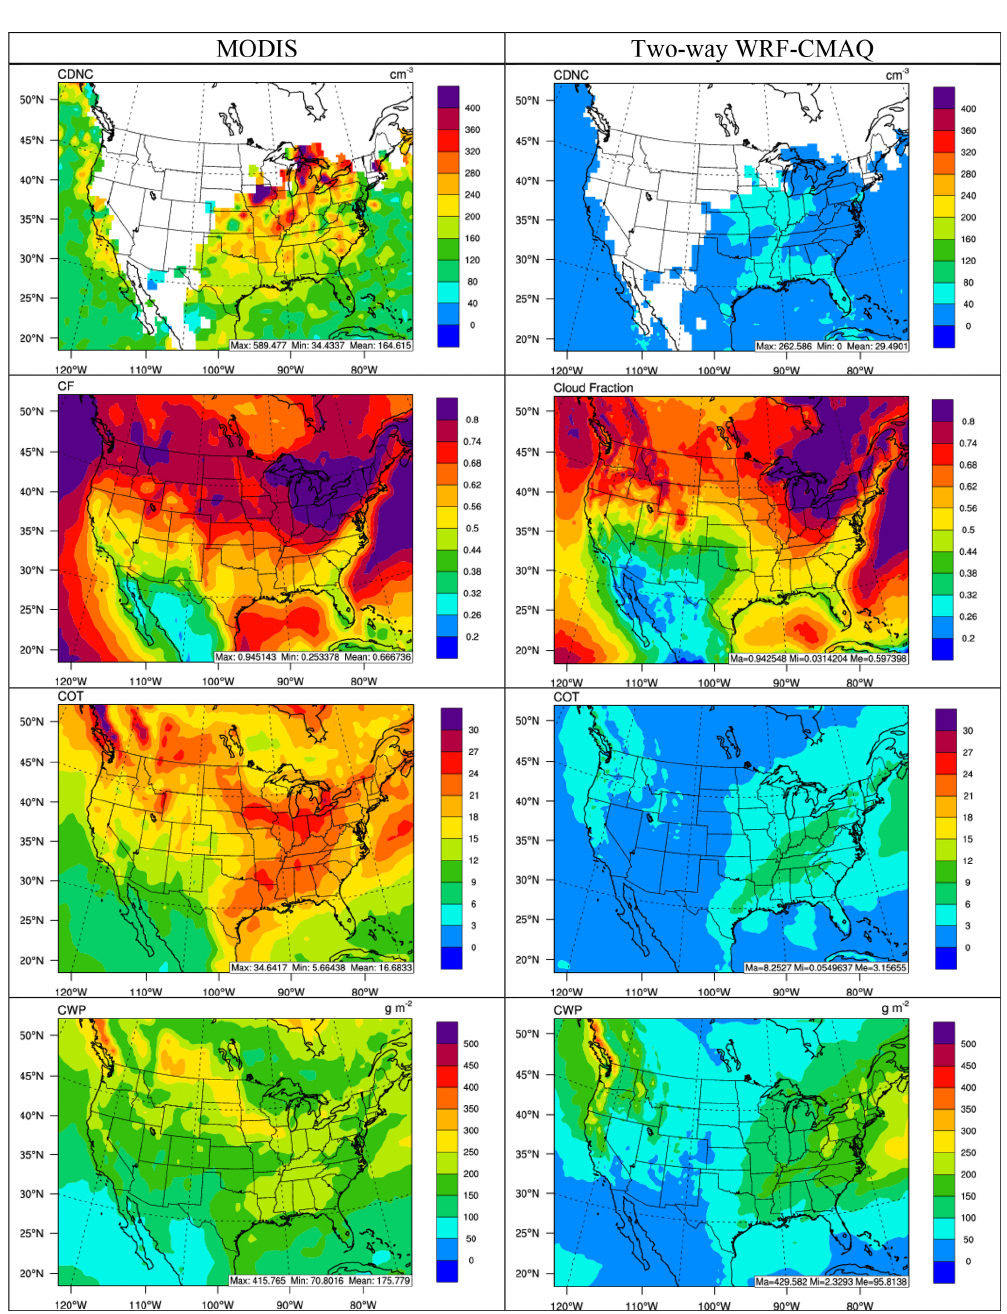
Figure 6. Spatial distribution of 5-year average major cloud variables (from top to bottom: CDNC, CF, COT, and CWP) between MODIS observations (left column) vs. two-way WRF-CMAQ (right column) in winter